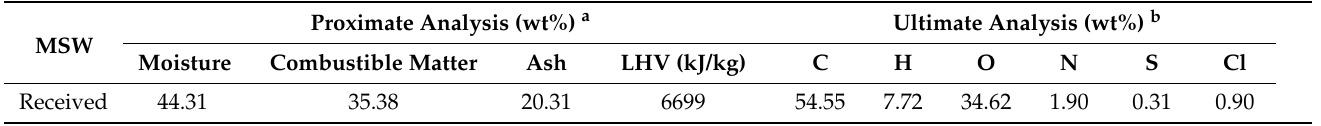
Table 1. The designed proximate and ultimate analysis of MSW.